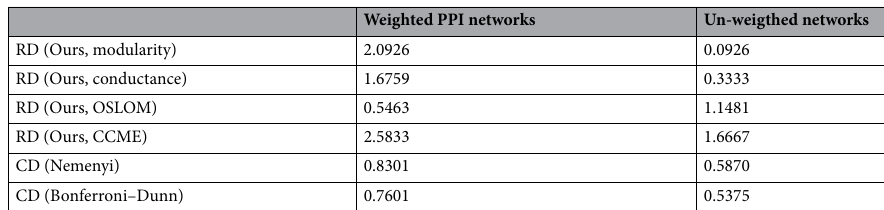
RD (Ours, modularity)